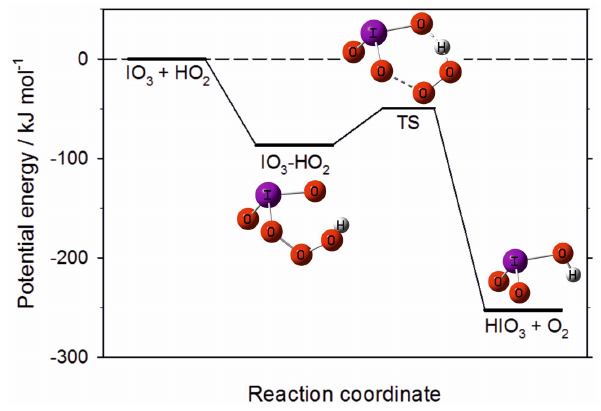
Figure 12. Potential energy surface for the reaction between IO 3 and HO 2 to produce HIO 3 , calculated at the B3LYP/gen level of theory (see text for further